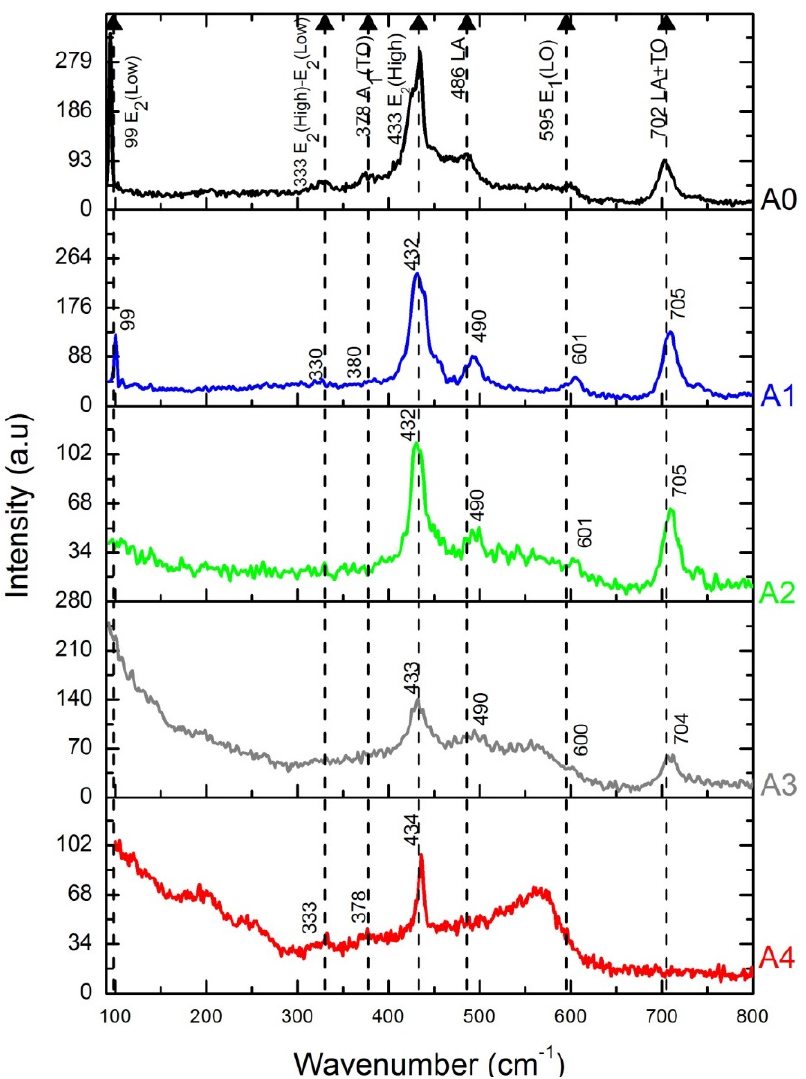
Figure 3. Raman spectra. A0 sample is the ZnO deposited without NiO at 500 °C. The deposit temperatures of the ZnO:Ni samples were 500 °C, 400 °C, 350 °C, and 300 °C labeled as A1, A2, A3, and A4, respectively. The vibrational modes E2 (low, ~101 cm − 1 ) and E2 (high, ~430 cm − 1 ) are related to the hexagonal structure of the ZnO. The vibrations modes ~490 cm − 1 and ~708 cm − 1 are related to defects